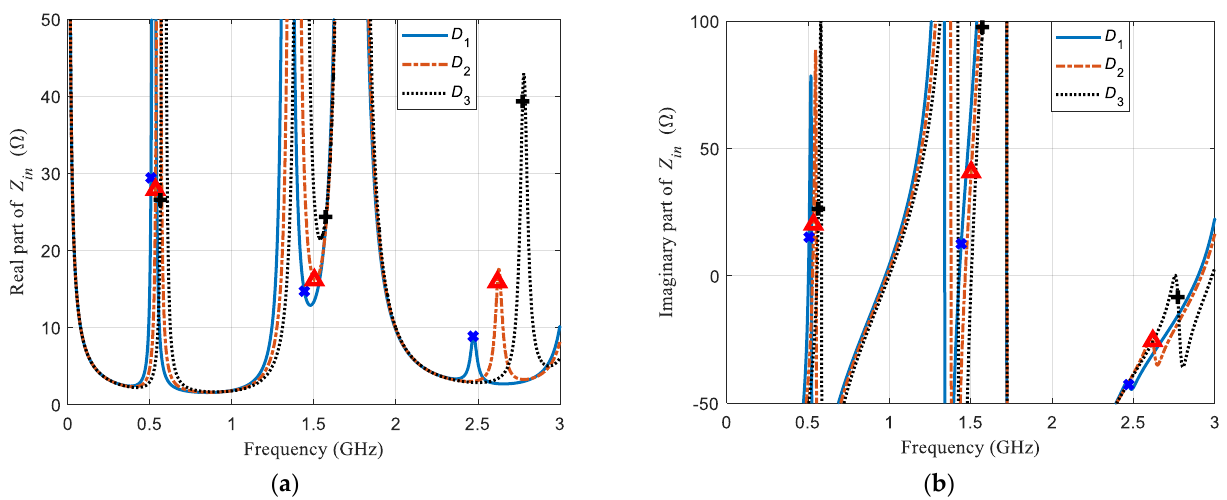
Figure 4. ( a ) Real part, and ( b ) imaginary part as a function of frequency of the input impedance of the sensor for configurations D 1 (blue solid line), D 2 (red dashed-dotted line), and D 3 (black dotted line). Blue x symbols, red ∆ symbols, and black + symbols are placed at the resonant frequency values for the three first modes of configuration D 1 , D 2 , and D 3 , respectively.